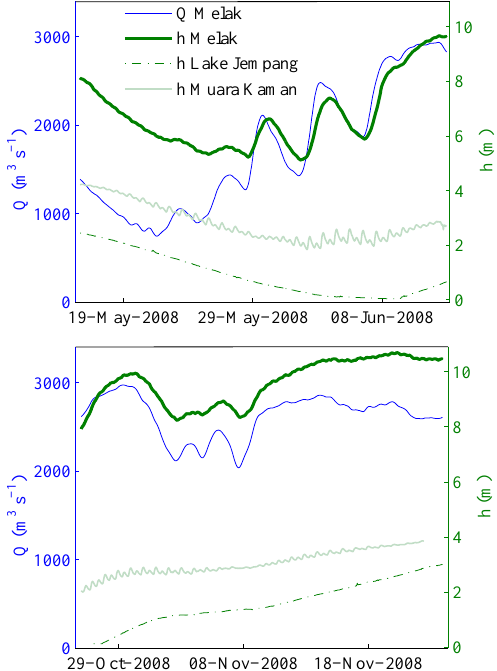
Fig. 13. Water stage and discharge during lake emptying (top) and during lake filling (bottom). Muara Kaman, where the tidal signal was observed during most of the measurement period, is located downstream of the Mahakam lakes area about 170km from Melak.